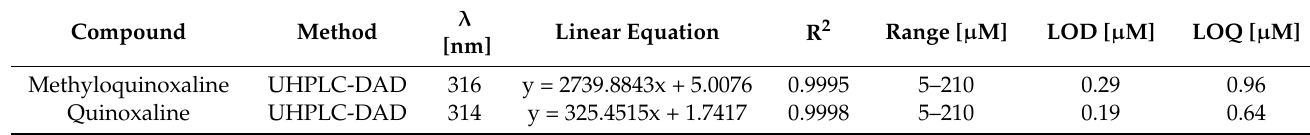
Table 4. Validation parameters of the UHPLC-DAD